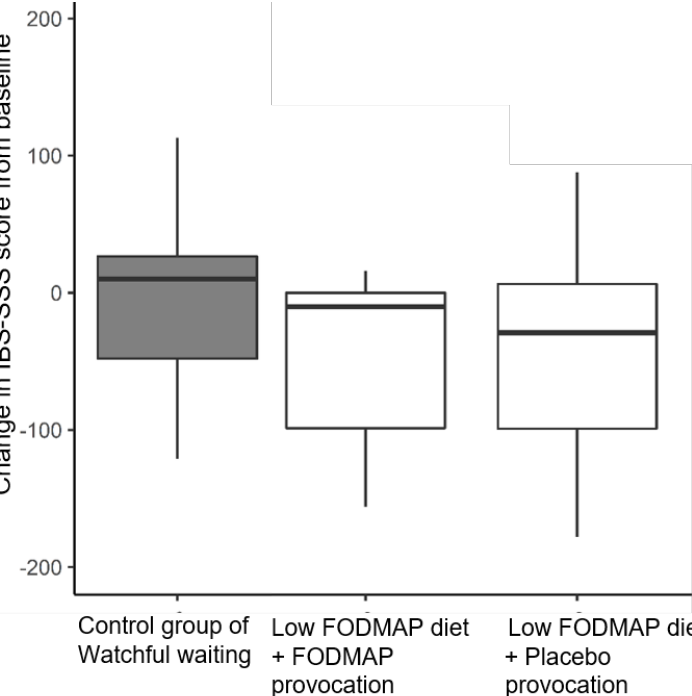
Figure 3. While on watchful waiting, the controls did not change their IBS-SSS scores from baseline. Patients on the low-FODMAP diet experienced no reductions in their IBS-SSS score after the combined time period of first open-label low-FODMAP diet and subsequent provocations with either placebo or FODMAPS. The lack of difference was a consequence of the provocation effects cancelling the initial dietary